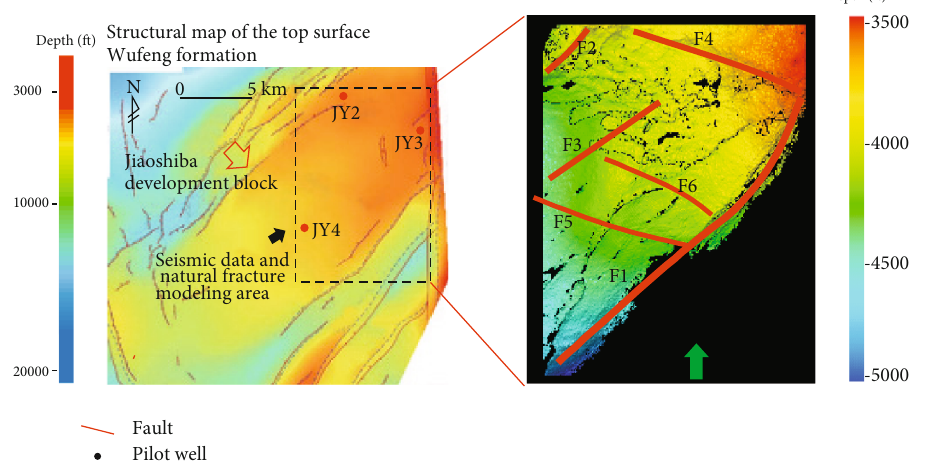
Figure 13: Large-scale fracture distribution of shale gas reservoirs in the study area. Based on seismic data interpretation and in situ stress analysis, six large-scale faults, namely, F1-F6, were characterized in the study